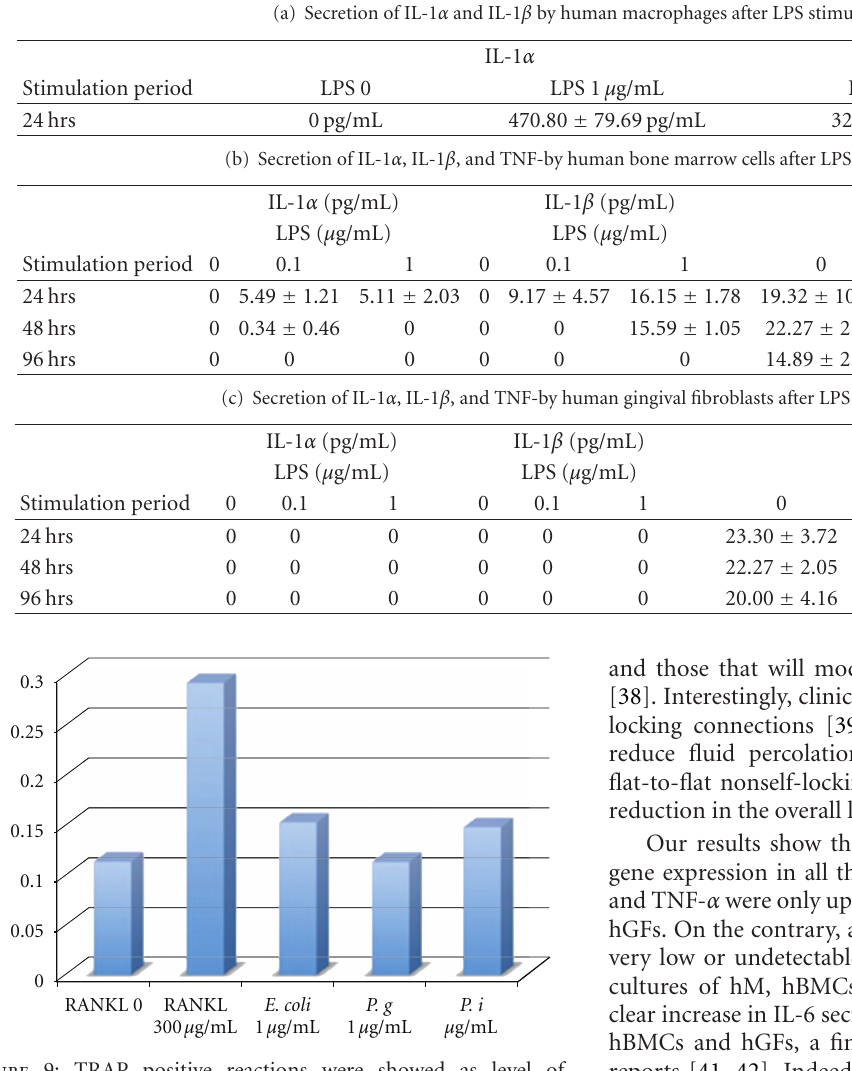
Figure 9: TRAP positive reactions were showed as level of absorbance in each group. The data were calculated by triplicate samples in each group. One day after mMO cells were seeded into 96 wells they were stimulated with E. coli , P. gingivalis , P. intermedia LPS for 3 days. 1 μ g/mL of LPS was added into the cell culture medium individually. As positive control, we used 300 ng/mL GST- RANKL which was treated the same way with LPS groups. Negative control was not including RANKL and